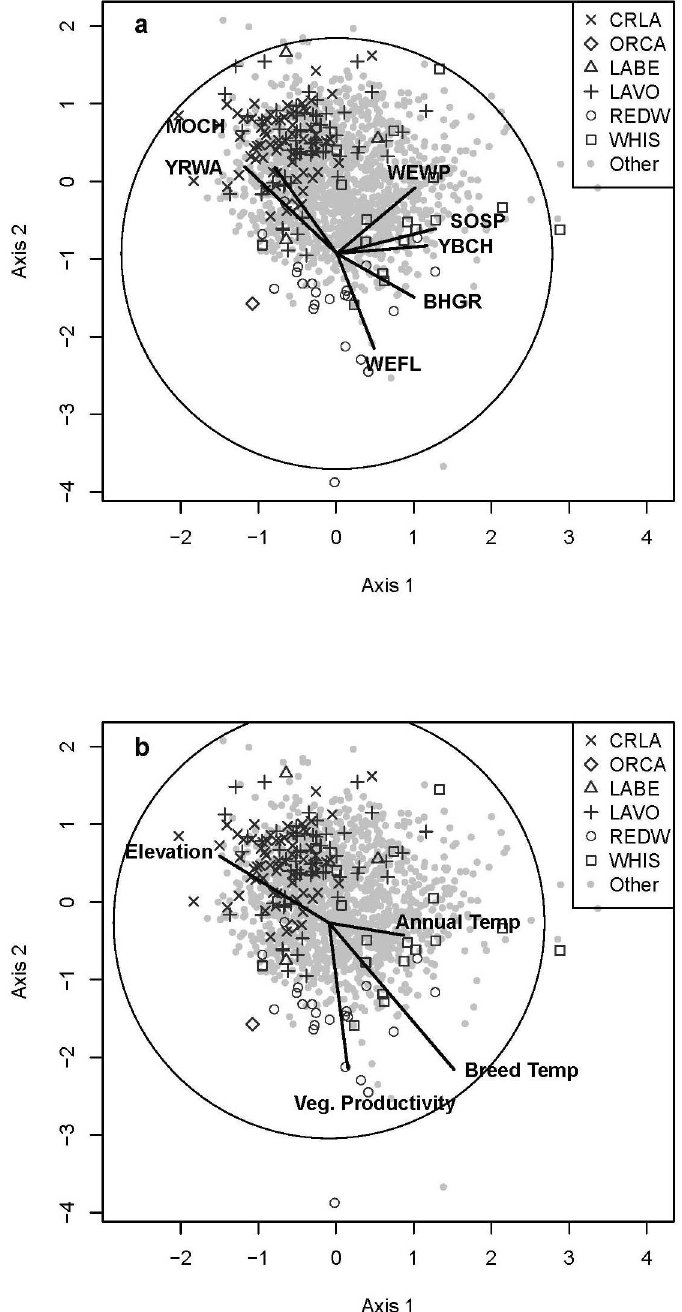
Fig 3. Bird Communities and Environmental Variables in Conifer Habitat. Relationship of individualbird sites (displayedby park unit) identifiedas conifer habitat (see text) using Non-metric Multidimensional Scaling. Biplots are direction and relative strength of Pearson correlationcoefficients (the circle indicates a correlationof 1) between bird sites and (A) underlying bird species with a rho of > 0.5 and (B) environmental variablesthat maximized the overallcorrelationthrough BIOENV (Table 4). See S1 Table for bird codes and S2 Table for definitions and abbreviations of environmental